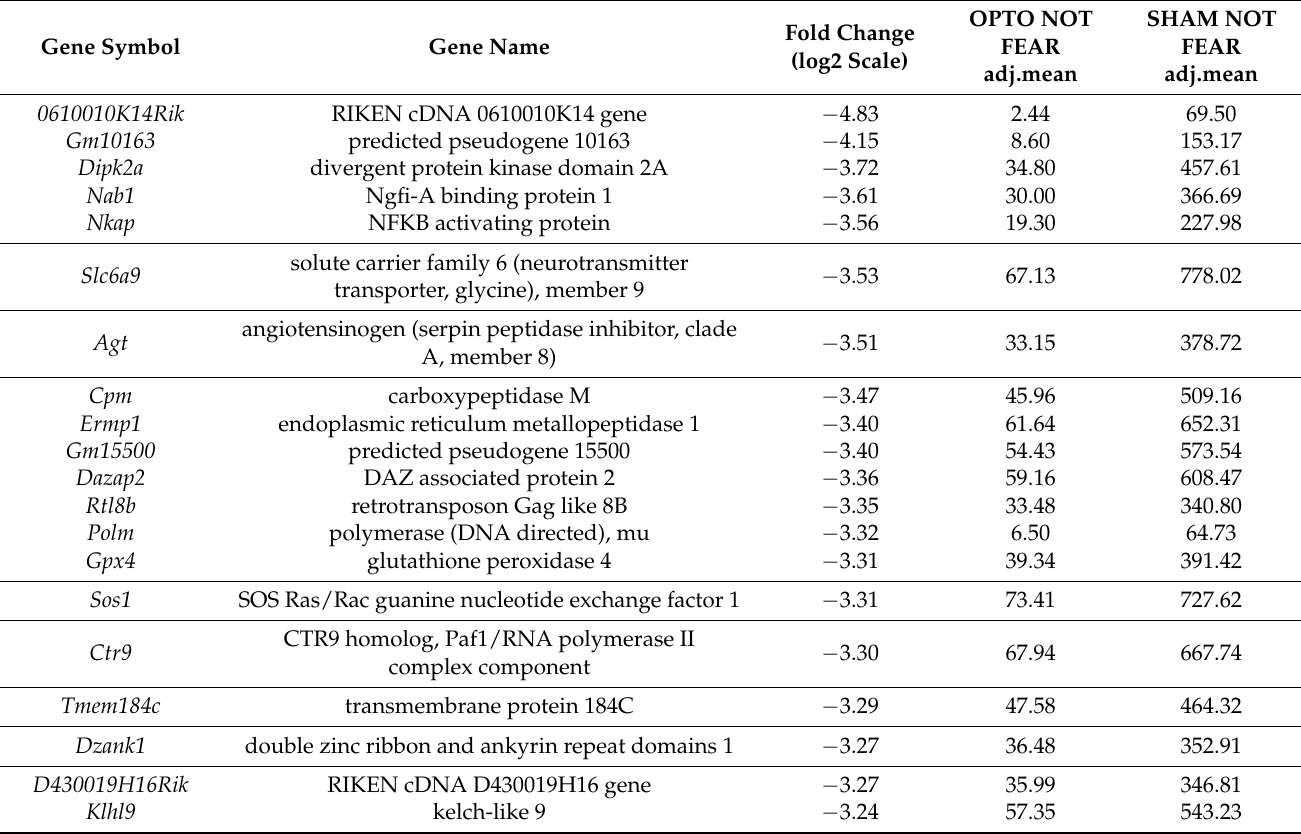
Table 2. The top 20 DEGs identified by differential expression profiling from RNA extracted by amygdala pyramidal neurons. Comparison between OPTO NOT FEAR vs. SHAM NOT FEAR